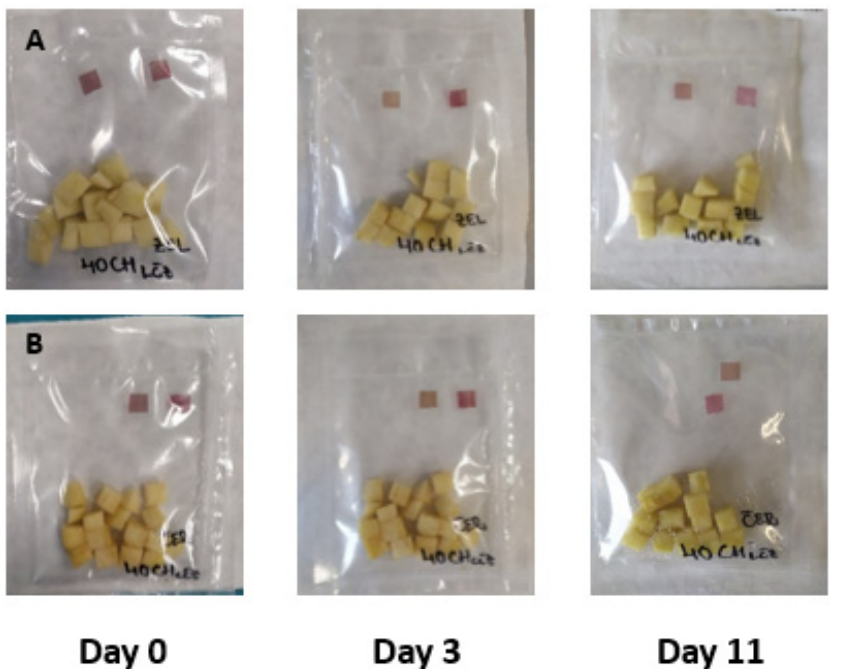
Figure 3. Green ( A ) and red ( B ) apples packaged with pieces of film made with the addition of red cabbage extract.